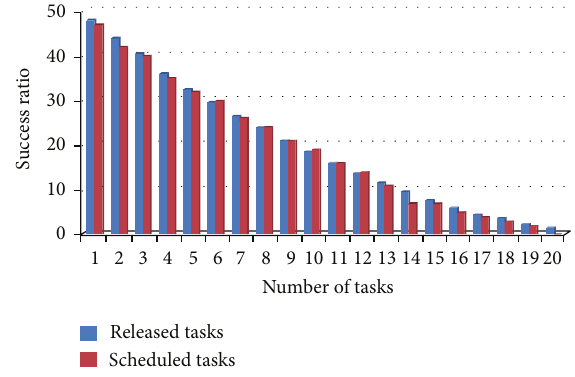
Figure 8: Success ratio of semipartitioned scheduling for the system load of 2.94.